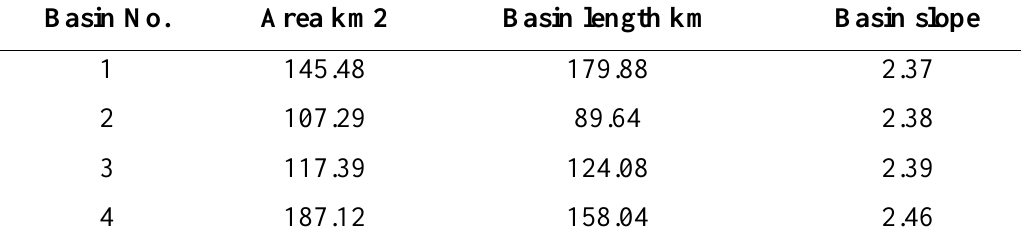
Table 4. The details of sub-basins of basin 3.